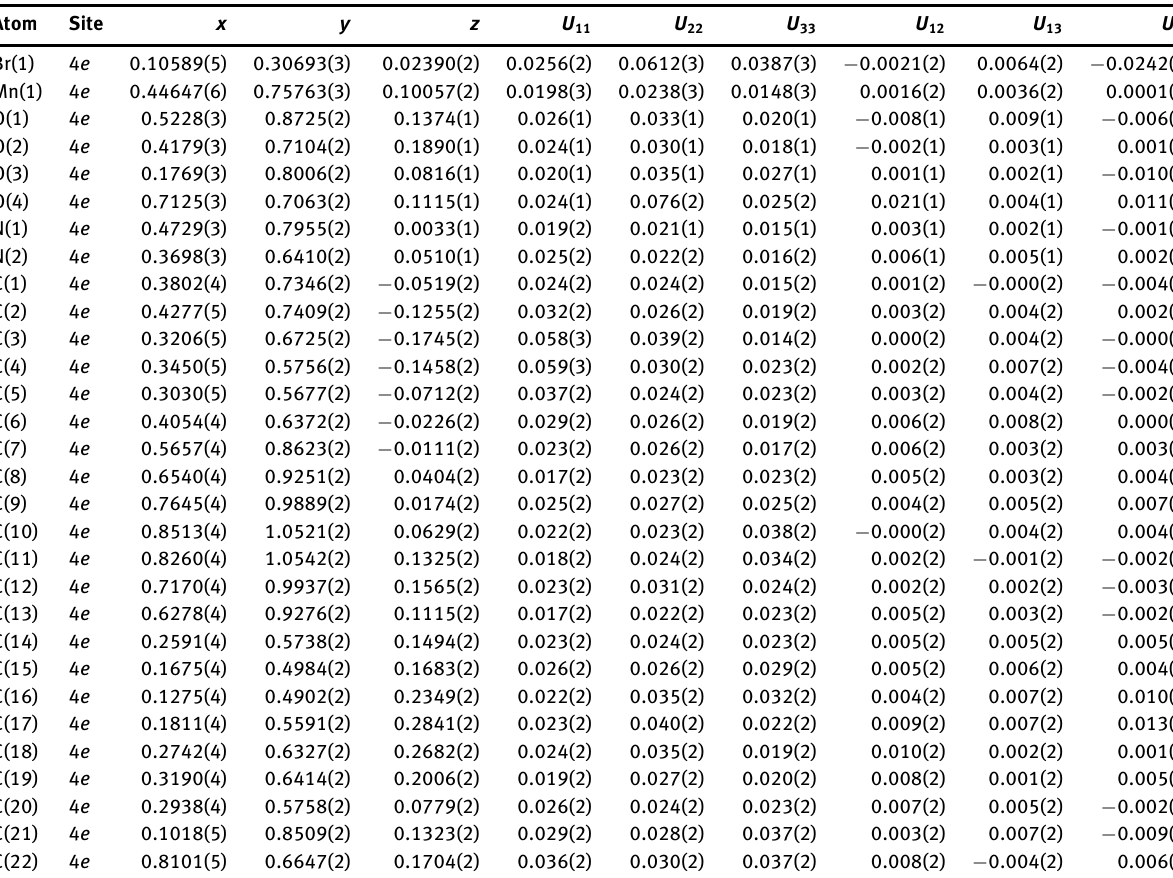
Table 3: Fractional atomic coordinates and displacement parameters (Å 2